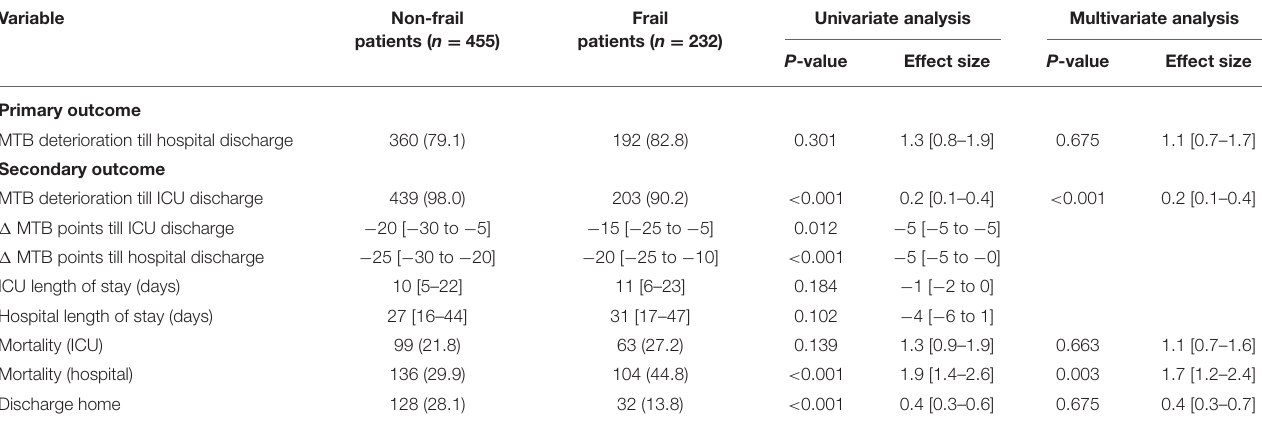
TABLE 3 | Primary and secondary outcomes in the propensity score matched